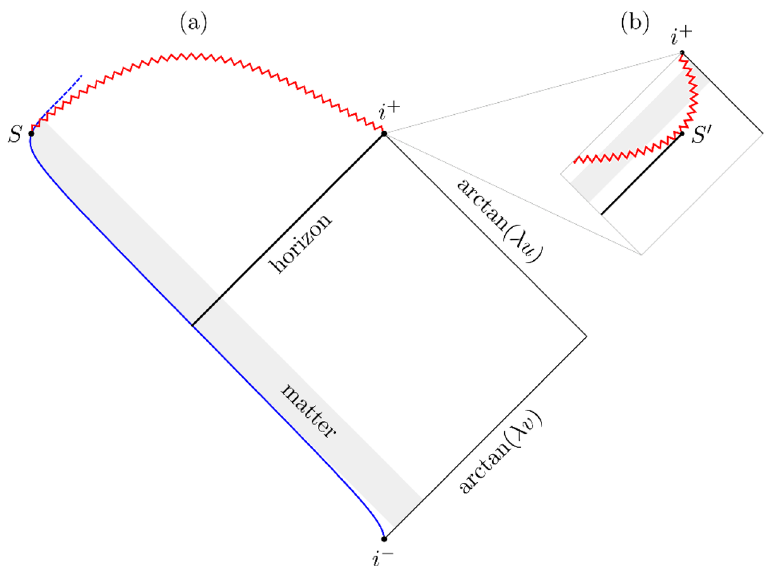
Figure 3 . (a) Analytic solution (3.23), (3.24), (3.25) describing black hole formation and